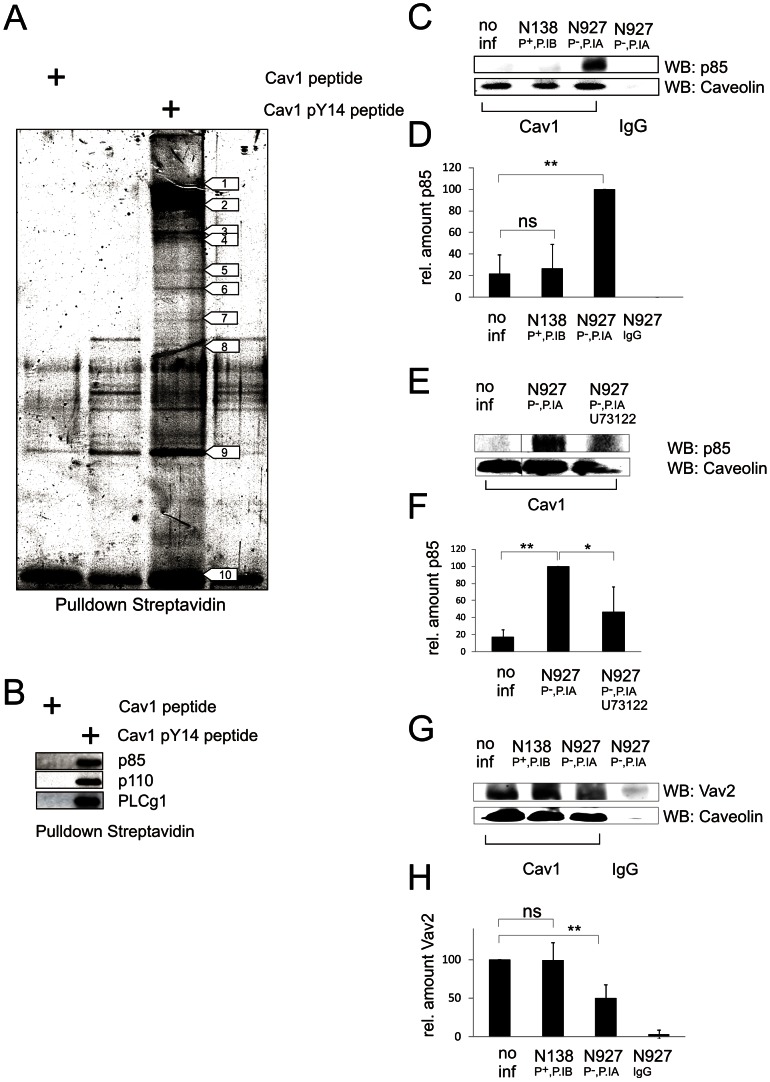
Identification of new Cav1 pTyr14 interaction partners.(a) Pull-down of Cav1-pY14 interaction partners. Biotin-labeled Cav1 peptides either with (Cav1 pY14 peptide) or without (Cav1 peptide) phosphorylated Tyr14 were used as baits to precipitate interacting proteins from AGS cell lysates using a streptavidin-agarose pulldown assay. Precipitates were separated by SDS-PAGE and proteins visualized by silver staining. The proteins enriched in the Cav1 pY14 pulldown (indicated by numbers; see also table 1) were identified by Maldi-MS/MS. (b) Western blot analysis of proteins precipitated from ME-180 cells using either biotin-labeled phosphorylated or non-phosphorylated Cav1 peptides as bait. PLCy1 as well as the regulatory p85 and catalytic p110 subunit of PI3K, are only detected in precipitates of the phosphorylated peptide with the respective primary antibodies. (c) PI3K-p85 interacts with Cav1 in N927 infected cells. Chang cells were infected with either N927 (PorBIA, P−) or N138 (PorBIB, P+) at an MOI 20 for 1 h or not infected (no inf). Endogenous Cav1 was precipitated and co-precipitated proteins were detected by Western blot with antibodies specific for Cav1 or PI3K-p85. (D) Relative amount of PI3 kinase quantified from (C). The bars represent the mean values ± SD of three independent experiments. (E) PI3 kinase recruitment to caveolin depends on activity of PLCy1. The experiment was performed as described in (C). 30 min prior to infection the PLCy1 inhibitor U73122 (10 µM) was added to the cells. (F) Relative amount of p85 quantified from three independent experiments. Shown are the mean values ± SD. (G) Interaction of Cav1 with Vav2 tested under conditions as described in (C). (H) Relative amount of Vav2 quantified from the experiment shown in (G). The bar graph shows the mean value of three independent experiments ± SD. p<0.05: *; p<0.01: **.